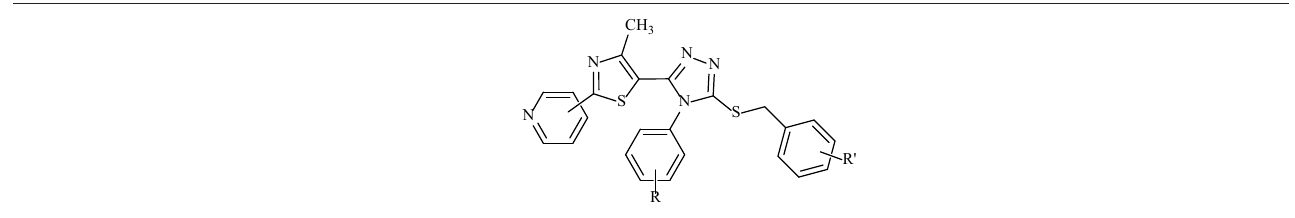
TABLE I - S tructures of the synthesized compound series V (A1-A24,